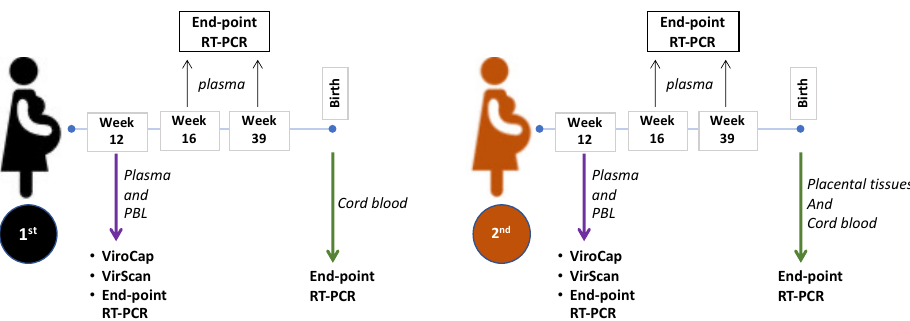
Figure 1. Summary of sample collection and assays. First trimester plasma and peripheral blood leukocytes (PBL) were collected/isolated (week 12 and 11 for 1st and 2nd pregnancy, respectively). ViroCap and VirScan were performed on the plasma while end-point RT-PCR was performed on plasma and PBL. Additional samples collected during the 2nd and 3rd trimesters (as indicated in weeks) were assayed with RT-PCR. At birth, placental tissues (only 2nd pregnancy) and cord blood were collected for RT-PCR assays.